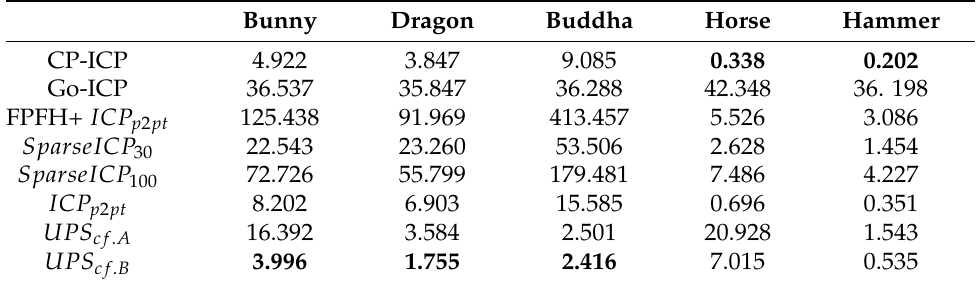
Table 2. Running time to align pairs of clouds under known ground truths. Bunny Dragon Buddha Horse Hammer